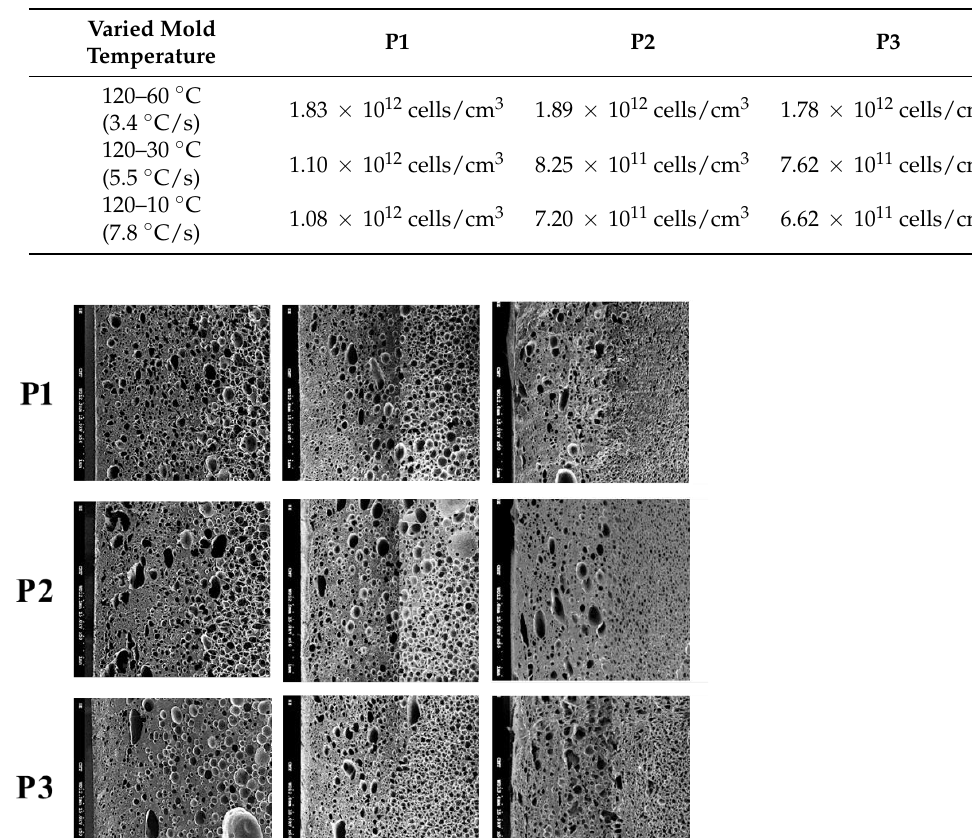
Table 9. Averaged cell density at different DMTC situations (cooling rate).